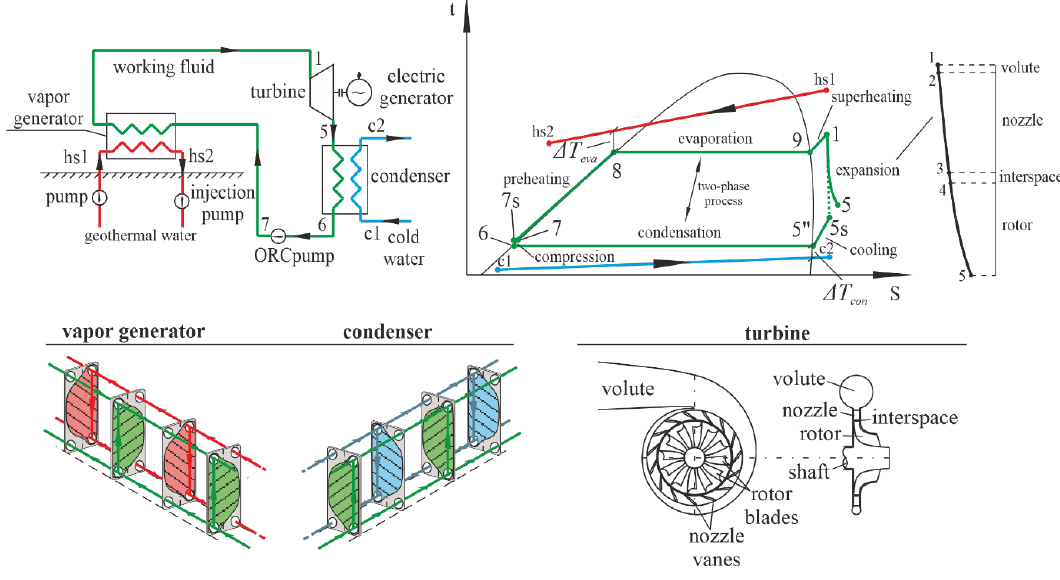
Figure 1. ORC system and modelling assumptions.